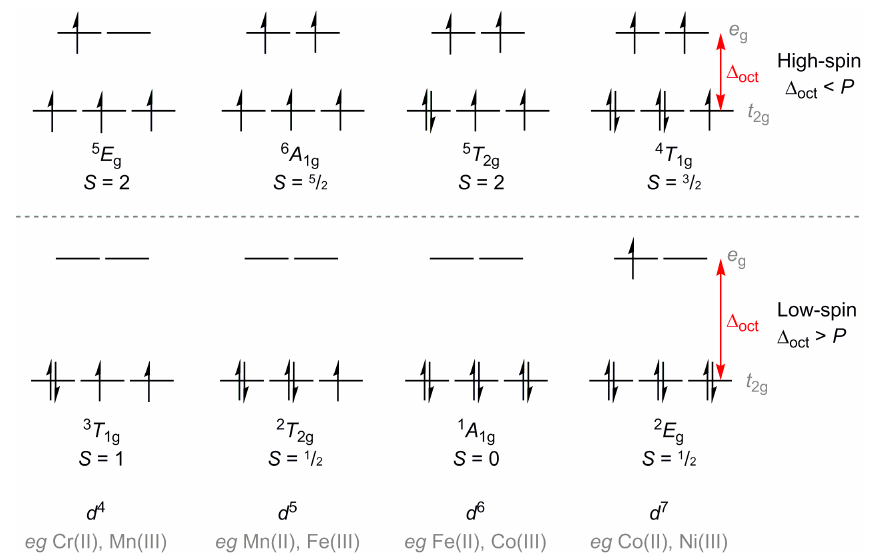
Scheme 1. High-spin and low-spin electron configurations of d 4 – d 7 transition ions in an octahedral ligand field, with their weak-field term symbols and spin quantum numbers [2].